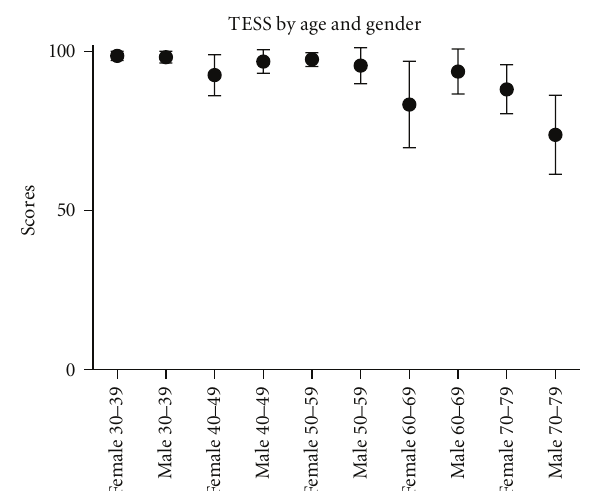
TESS by age and gender